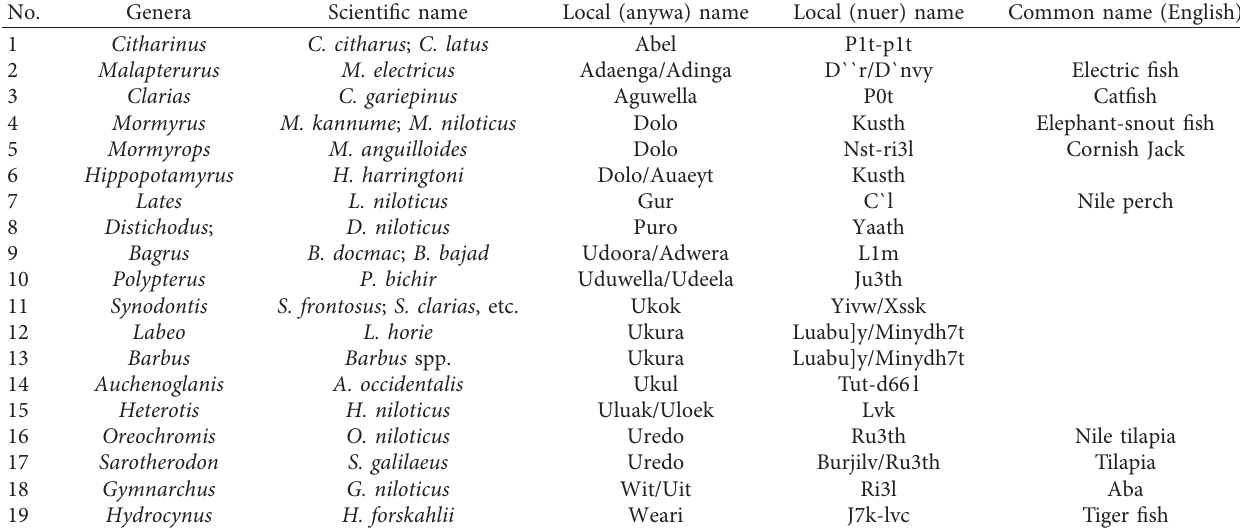
Table 1: Commercially important fish species in the Gambella region